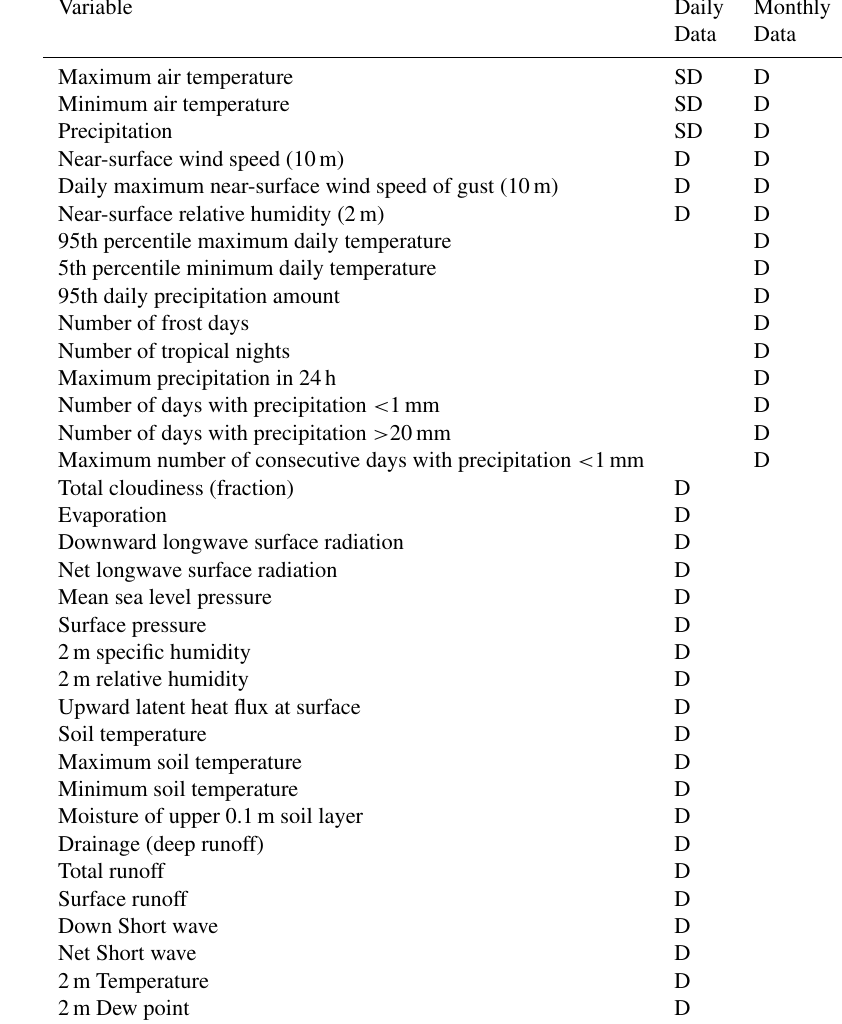
Table 5. List of variables considered in statistical and dynamical regionalisation (daily data) and dynamical regionalisation in AEMET. S (D) stands for statistical (dynamical)